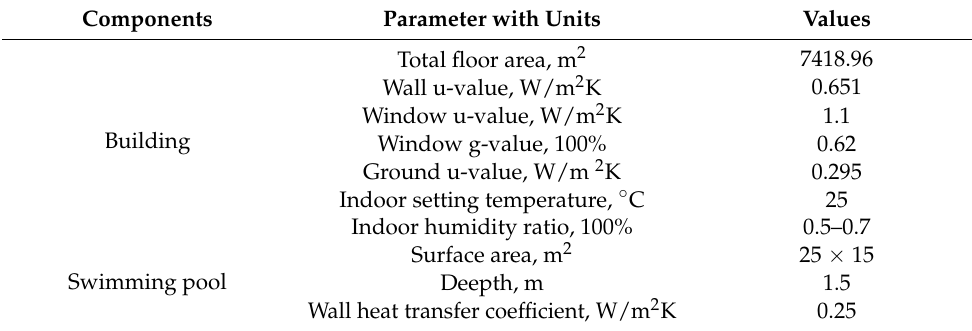
Table 3. Building and swimming pool